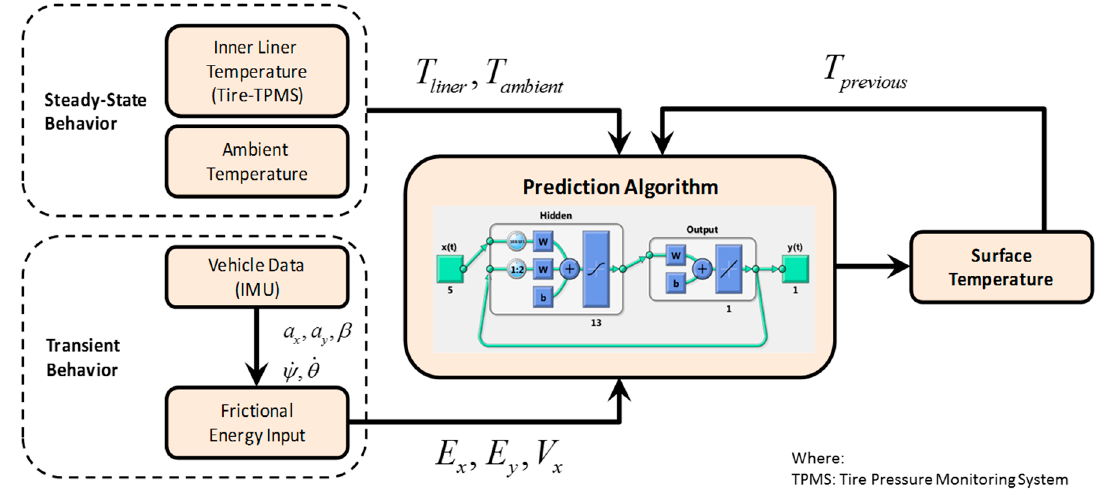
Figure 20. Surface temperature prediction model—flowchart.